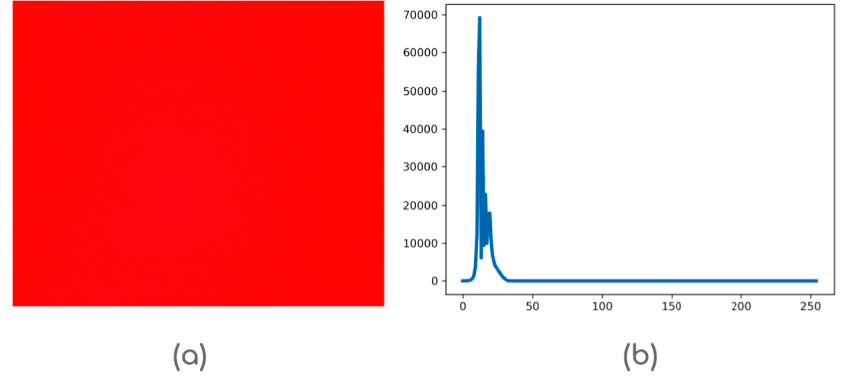
Figure 5. Example of a fingertip image ( a ) with its corresponding histogram ( b ).